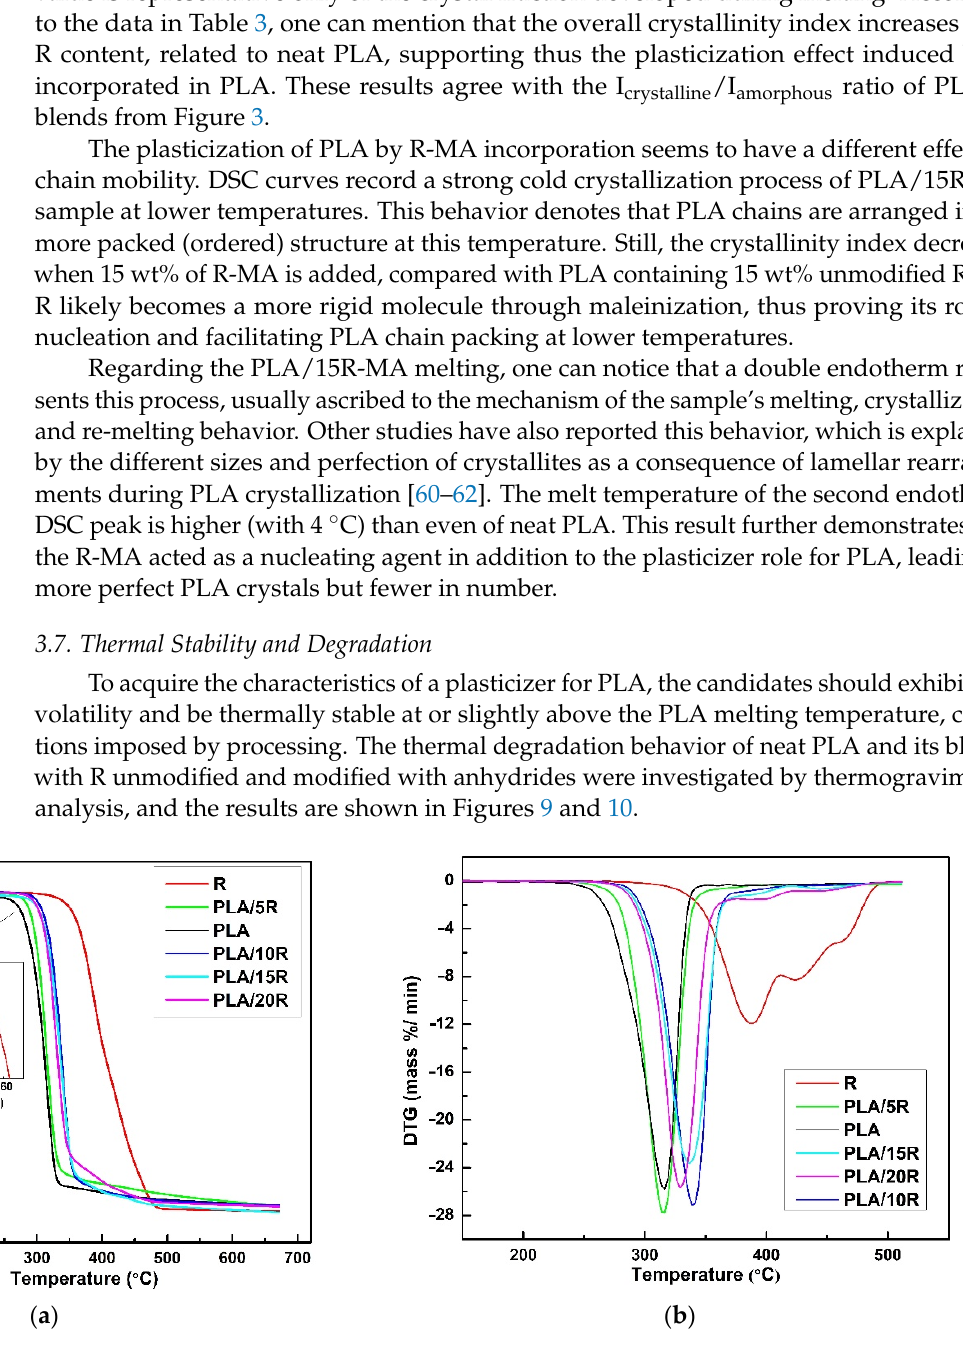
Figure 9. TG ( a ) and DTG ( b ) thermograms of castor oil (R), neat PLA and PLA/R blends. Table 4. Thermogravimetric data of neat PLA and PLA/R blends .